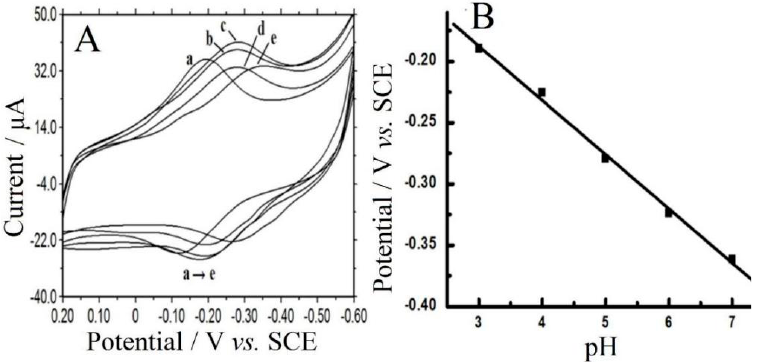
Figure 6. ( A ) CV of CTS/CMS-Hb/CILE in 0.1 mol·L − 1 different pH PBS (from a → e: 3.0, 4.0, 5.0, 6.0, 7.0), scan rate: 0.1 V·s − 1 ; ( B ) the relationship of E 0 ′ with pH.